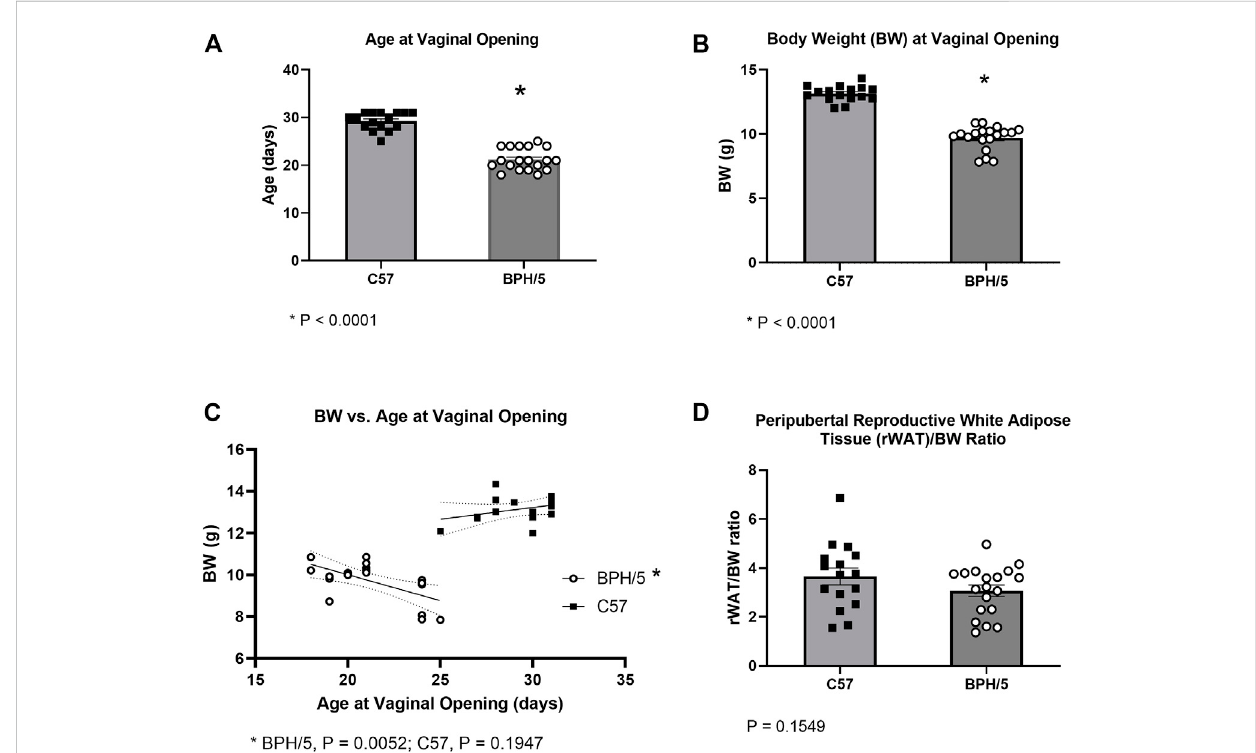
FIGURE 1 Precocious pubertal development occurs in the preeclamptic-like BPH/5 female offspring. (A) Age at the day of vaginal opening in BPH/5 and C57 female offspring ( n = 16 – 19/group, Student ’ s t-test, mean ± SEM, * p < 0.0001). (B) Body weight (BW) at the day of vaginal opening in peripubertal BPH/5 and C57 female offspring ( n = 16 – 19/group, Student ’ s t-test, mean ± SEM, * p < 0.0001). (C) A negative correlation occurs between BWand age at vaginal opening in BPH/5 females ( n = 19, Simple linear regression with 95% con fi dence bands of best- fi t line, p = 0.0052), while a signi fi cant correlation was not seen in C57 controls ( n = 16, Simple linear regression with 95% con fi dence bands of best- fi t line, p = 0.1974). (D) Reproductive white adipose tissue weight correctedto BW(rWAT/BW ratio) inperipubertal BPH/5 and C57 femalesatthe dayofvaginalopening ( n =16 – 19/group,Student ’ s t-test, mean ± SEM, p =